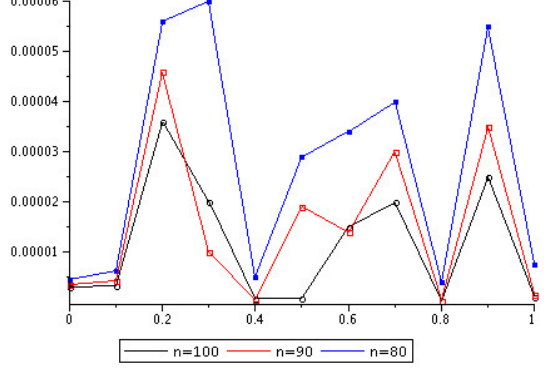
Figure 3. Absolute errors for n = 80 , 90 , 100 of Example 3.